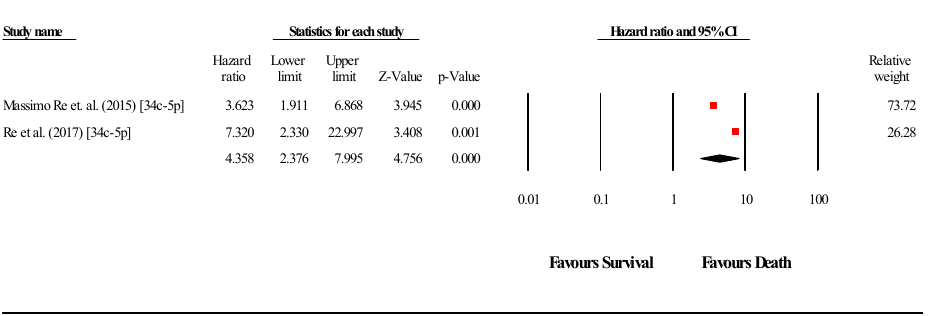
Figure 8. Forest plot for miR-34c-5p association with OS.